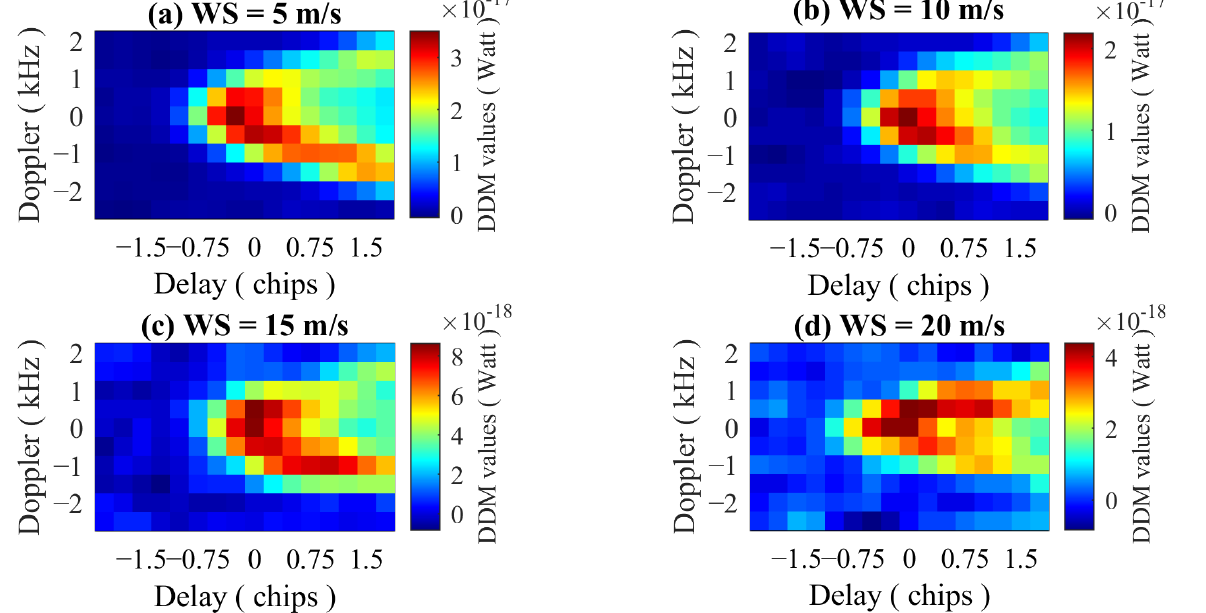
Figure 2. DDMs under different wind speed (WS) conditions.